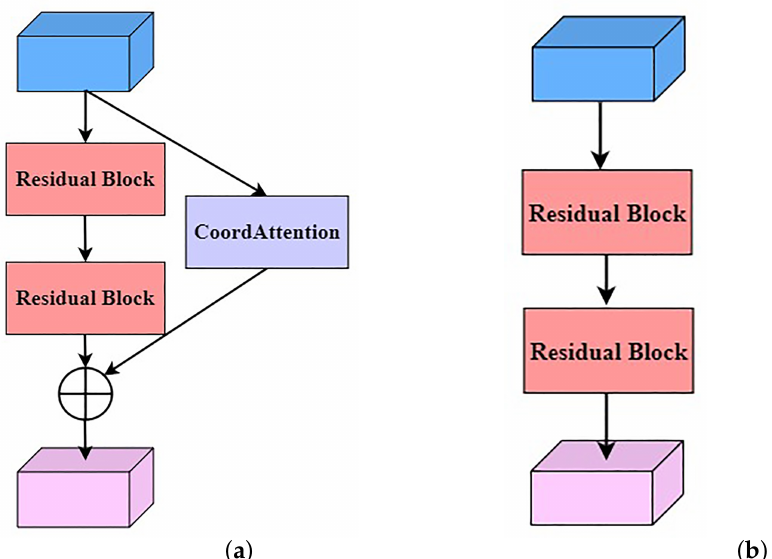
Figure 3. ( a ) Residual network A based on the residual block and the CoordAttention mechanism and ( b ) residual network B based on the residual